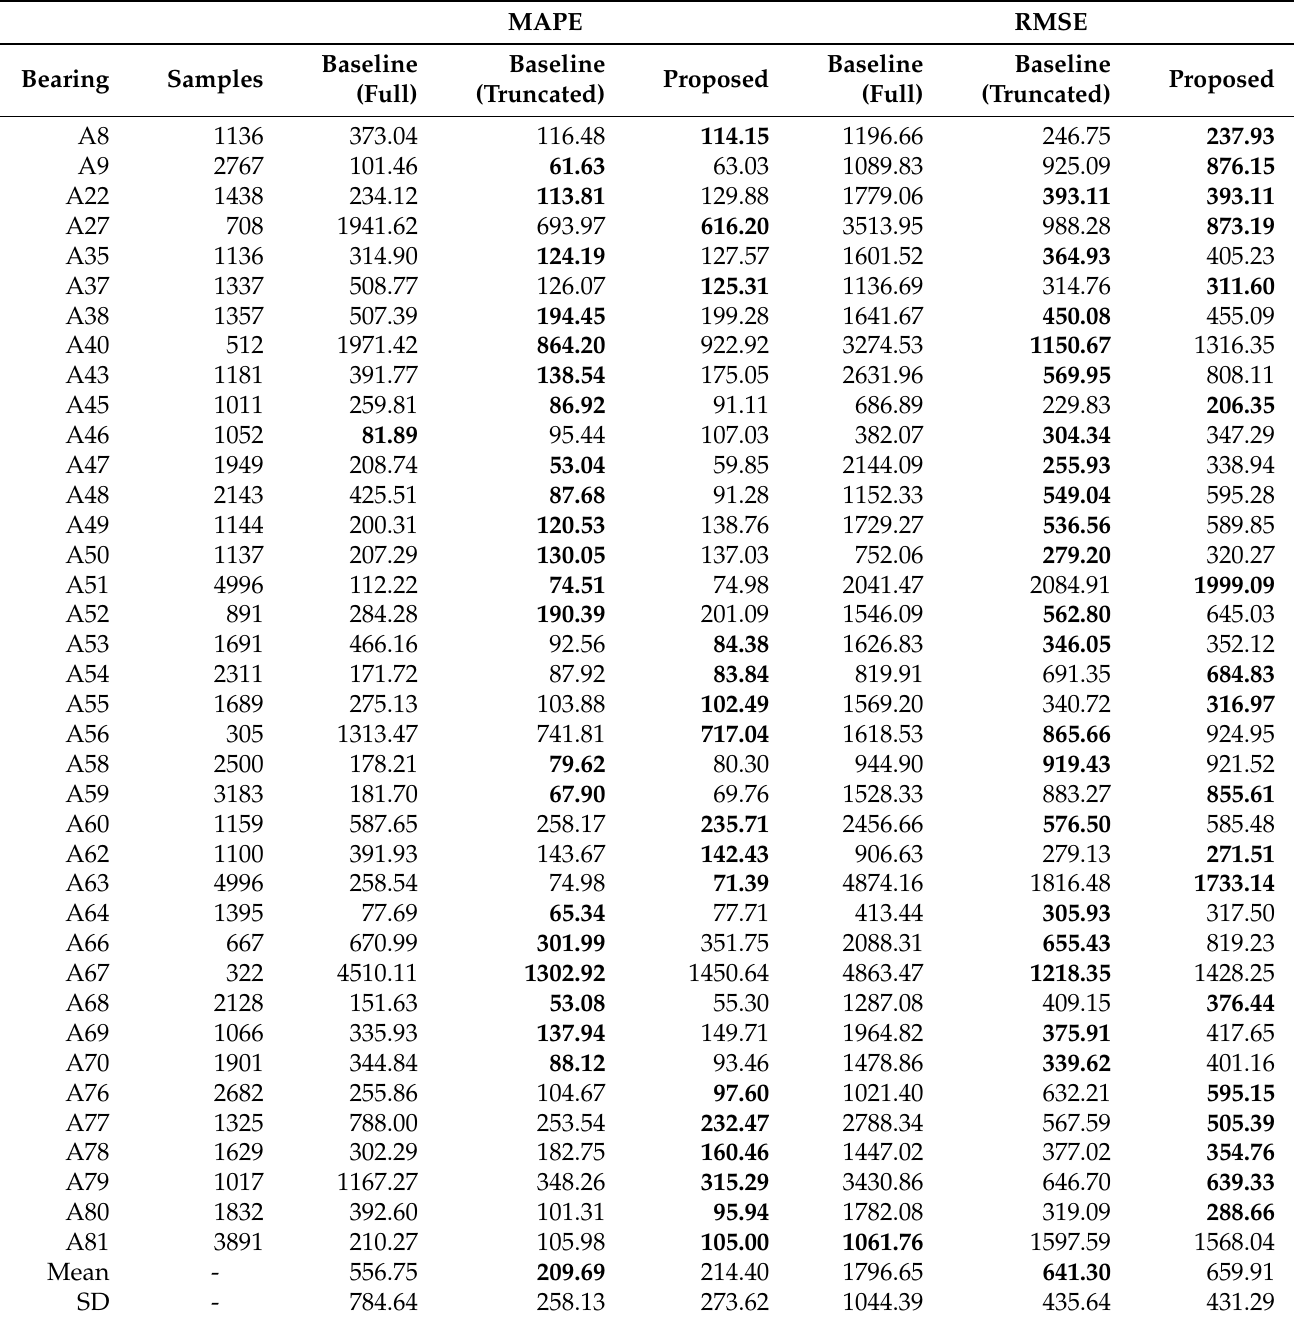
Table 8. Results obtained on the Smart Maintenance Living Lab dataset. Highlighted in bold the best result per